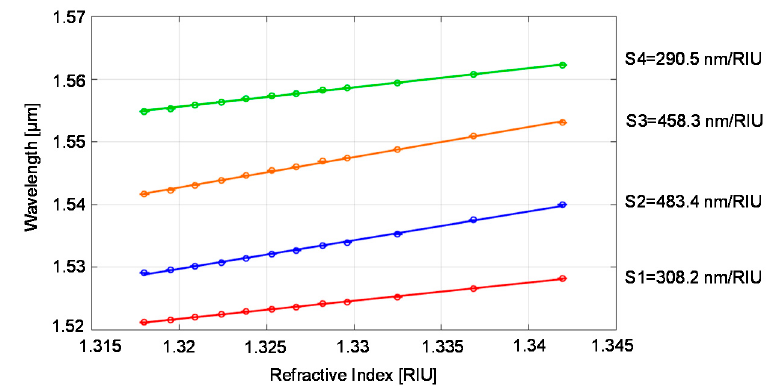
Figure 10. Wavelength positions of R minima as a function of glucose solution RI: mean values (empty circles) and standard deviations (error bars) calculated on three spectral acquisitions on a rectangular tubing with d = 30 µ m, t f = t b = 21 µ m (nominal dimensions). Straight lines represent the best linear fitting of the data.